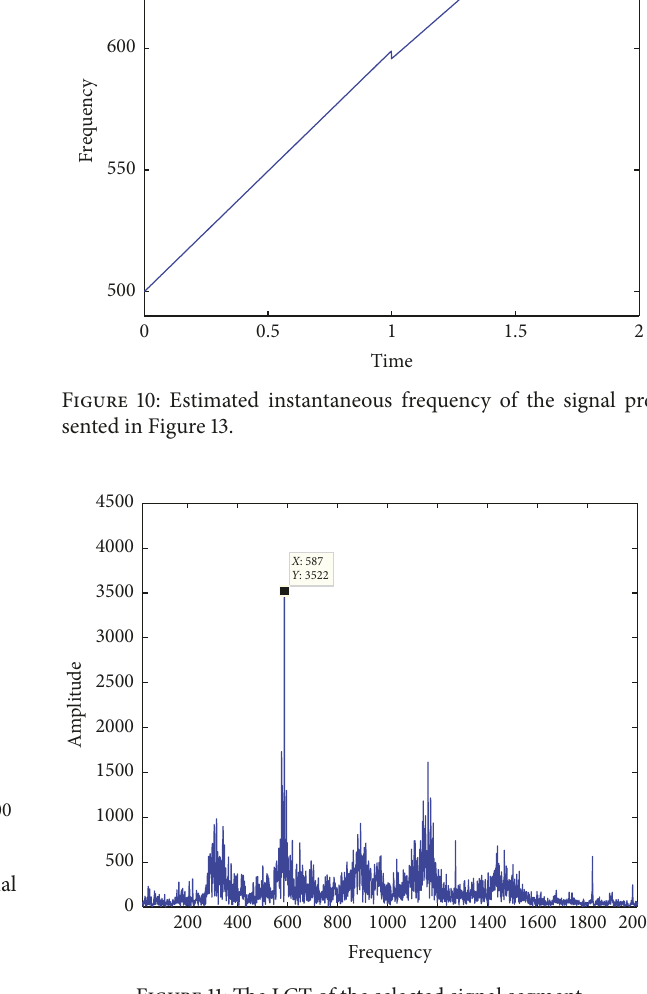
Figure 11: The LCT of the selected signal